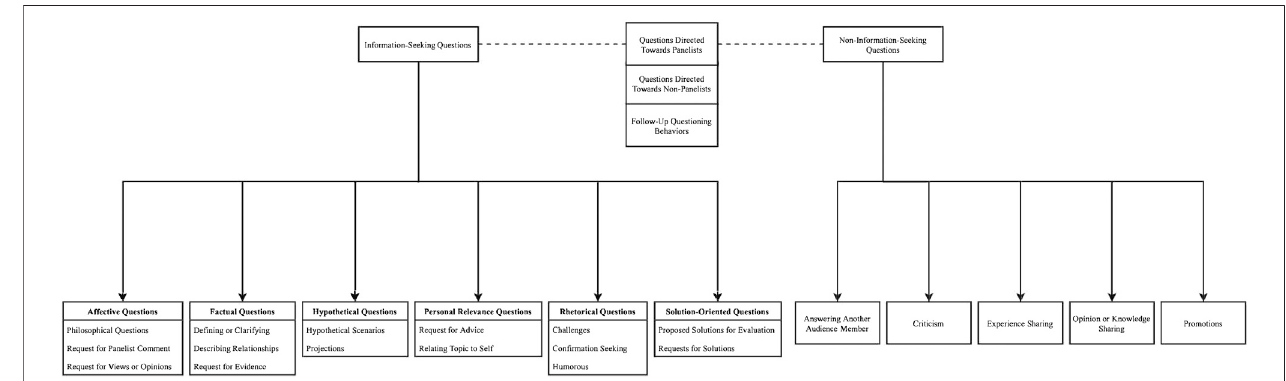
FIGURE 1 | The Nesseth taxonomy of questions based on learning